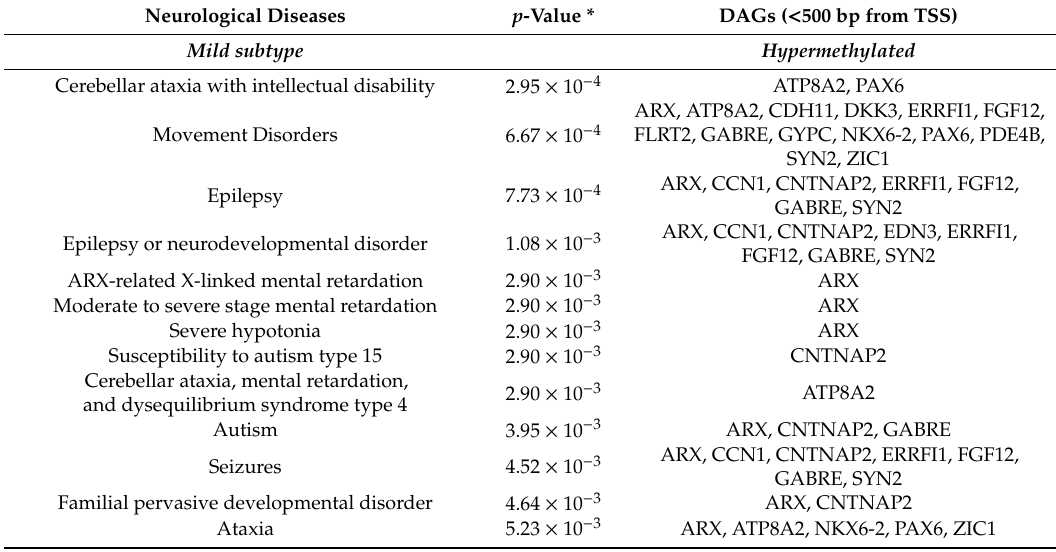
Table 6. Neurological diseases enriched among DAGs implicated by CpGs within 500 bp from the TSS in the mild